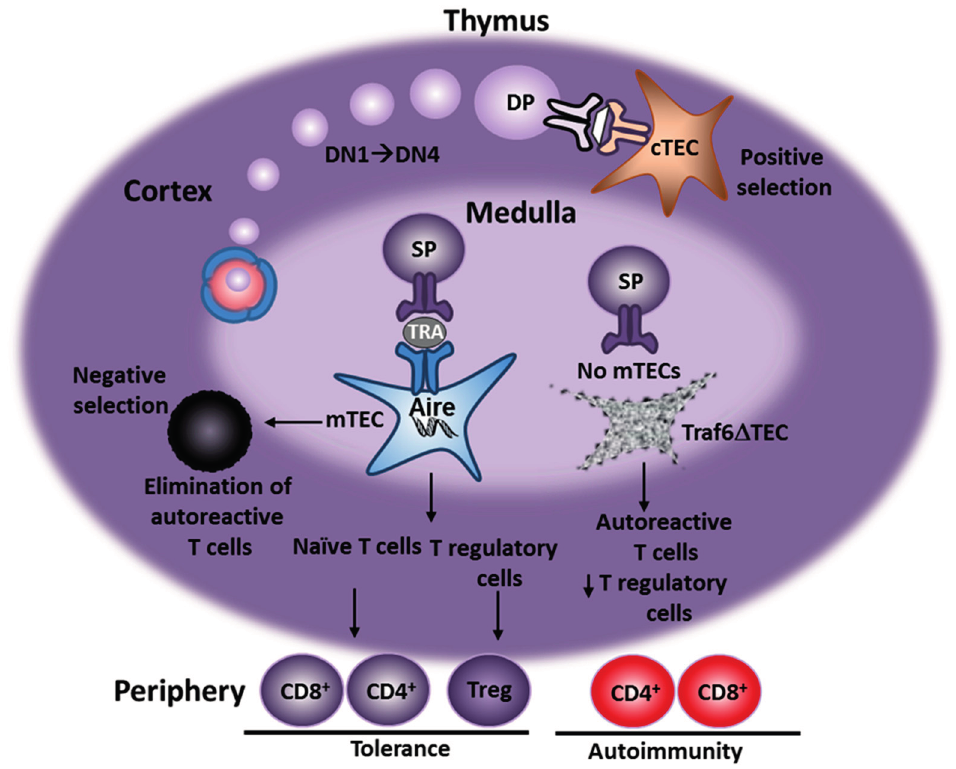
Figure 1. Schematic representation of T-cell selection and tolerance induction in the thymus. Bone marrow progenitors enter the thymus at the corticomedullary junction (CMJ) and migrate towards the cortex, where they differentiate into immature thymocytes lacking expression of the CD4 and CD8 coreceptors (double-negative 1-4, DN1-4). Upregulation of CD4 and CD8 gives rise to CD4 + CD8 + double-positive (DP) thymocytes whose T-cell receptor binds to self-antigens presented by cortical thymic epithelial cells (cTEC). A fraction of DP thymocytes are positively selected and differentiate into CD4 + or CD8 + single-positive (SP) T-cells. These migrate to the medulla, where they bind to tissue-restricted antigens (TRA) presented by medullary TECs (mTEC) and whose expression is regulated by Aire [30,31]. Autoreactive T-cells that bind to TRAs with high affinity are negatively selected. SP T-cells with weak affinity for TRAs are allowed to exit the thymus, whereas T-cells with intermediate affinity for TRAs become regulatory T-cells (Treg). mTEC depletion in Traf6 ∆ TEC mice leads to the production of autoreactive T-cells,